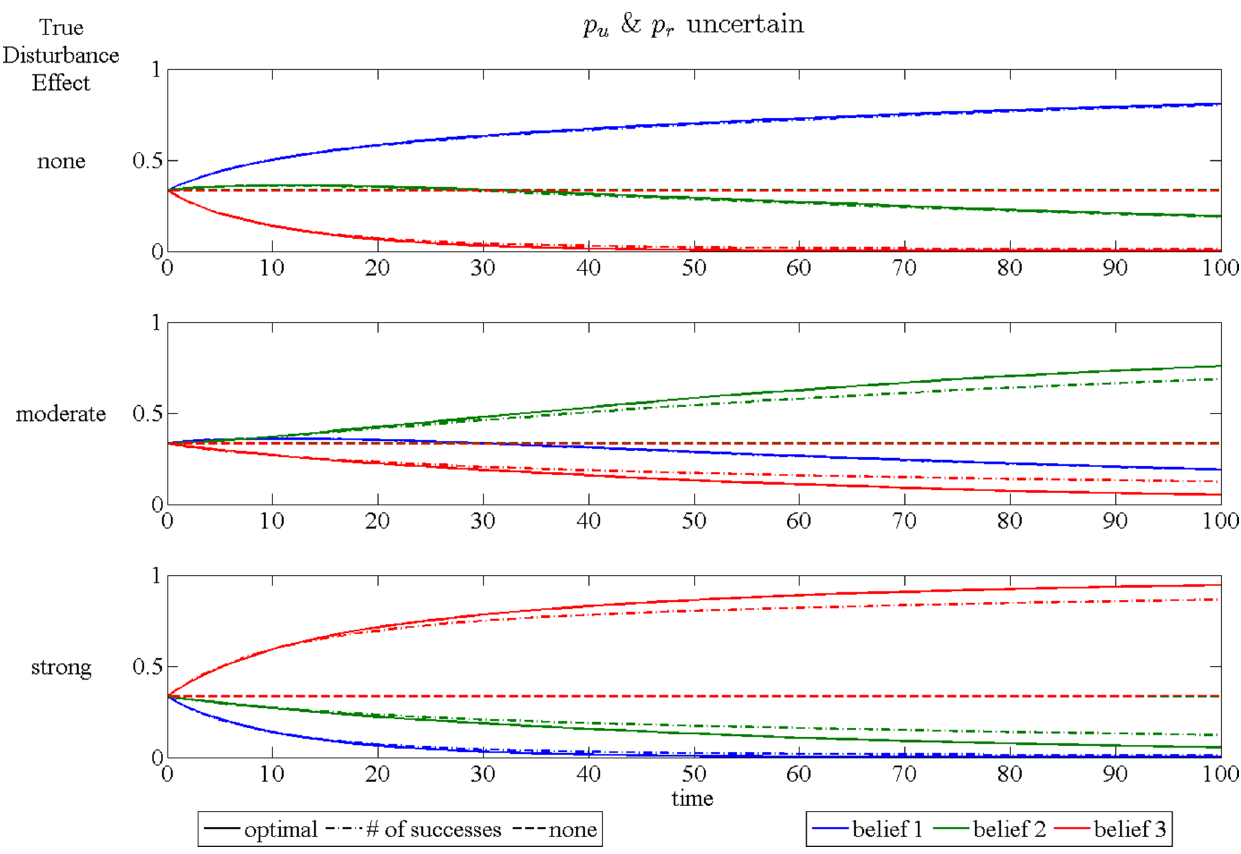
Figure 7. Time paths of expected beliefs when both p u and p r are uncertain . The three subplots represent cases for each of the three possible disturbance effect models. Each plot shows time paths of expected beliefs over 100 years. Line color is associated with the belief in a specific disturbance effect: blue – no disturbance, green –moderate disturbance, red – strong disturbance. Line type represents the signal used for updating beliefs: solid – full information, dash/dot – number of successes only, dashed – no signal.